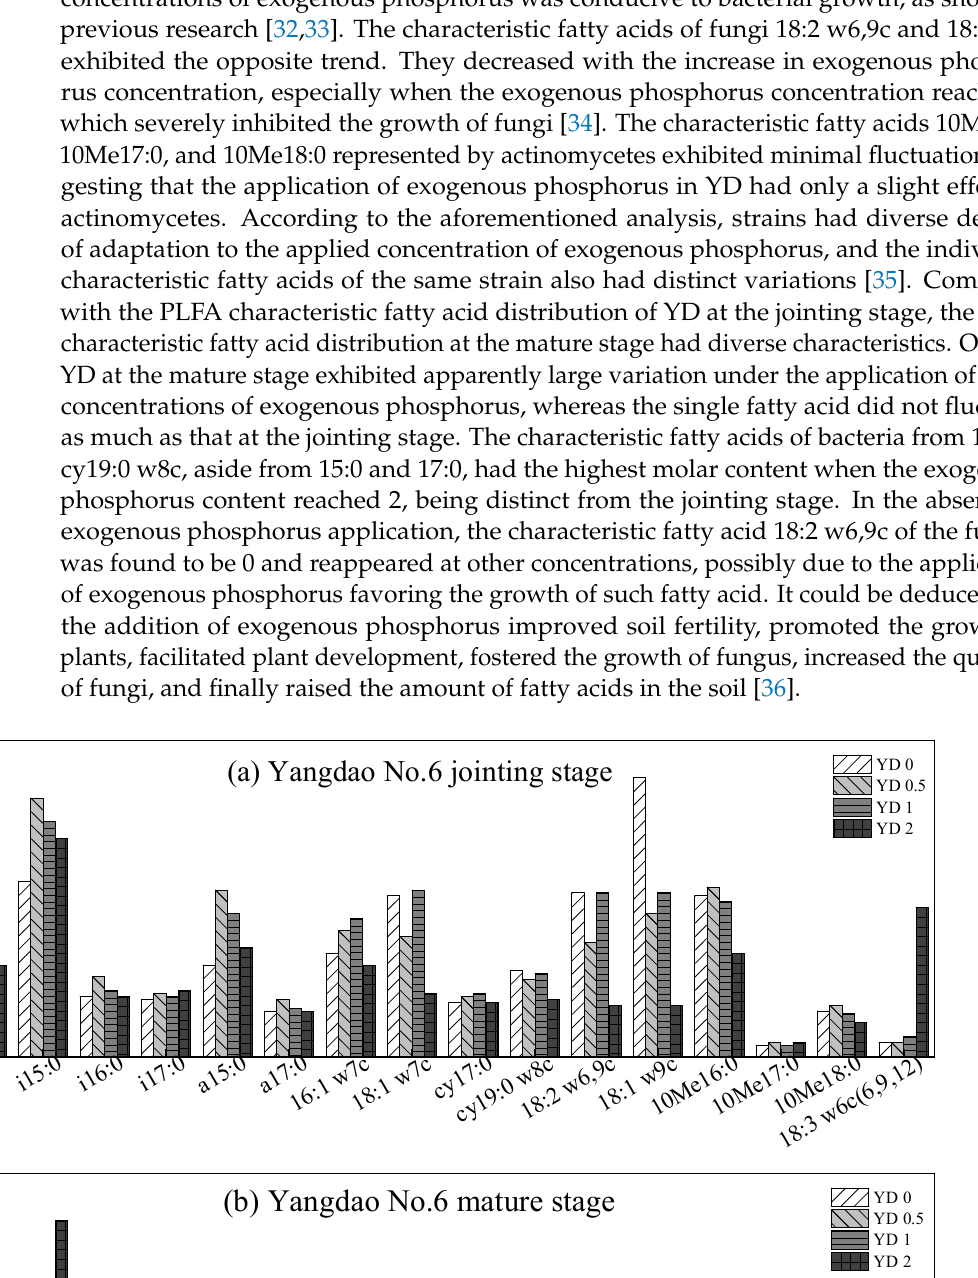
Table 3. The definition of each soil sample.